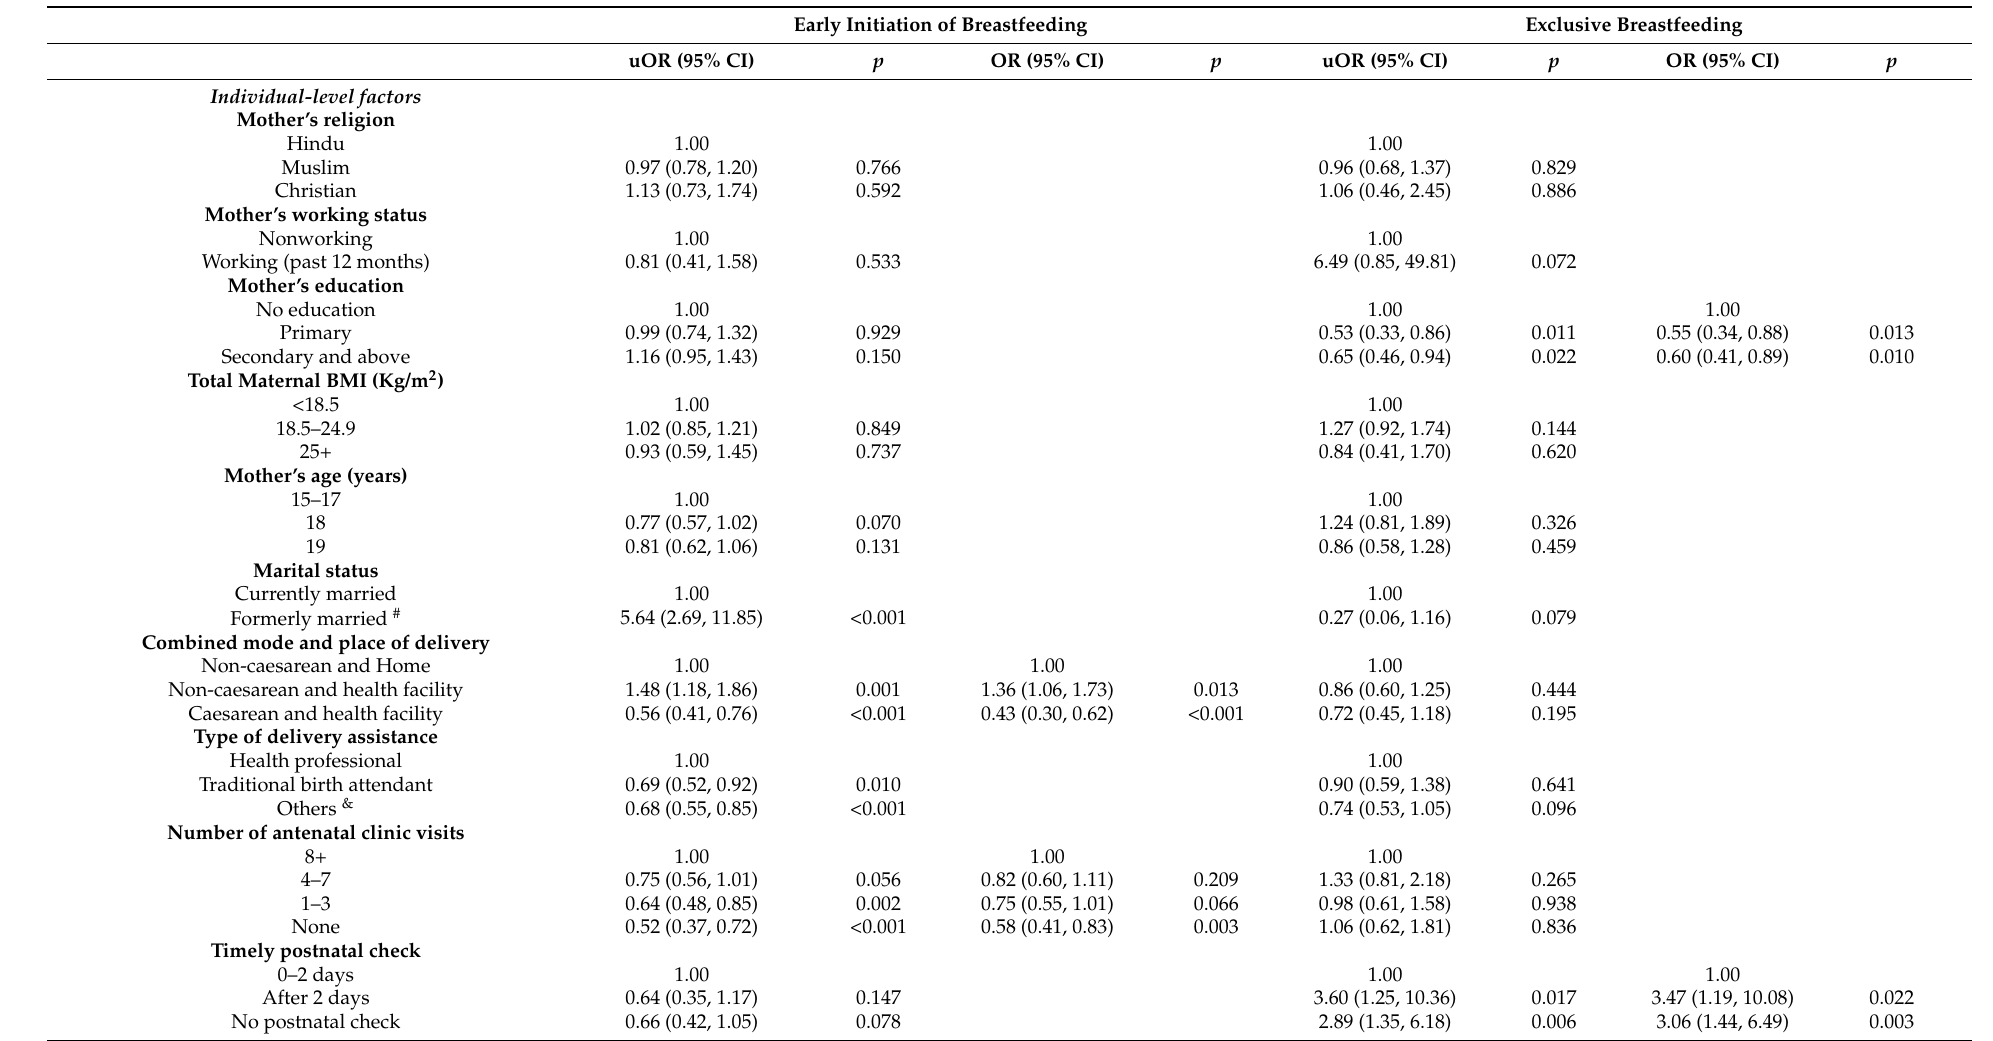
Table 3. Factors associated with early initiation of breastfeeding and exclusive breastfeeding in adolescent Indian mothers, 2015–2016